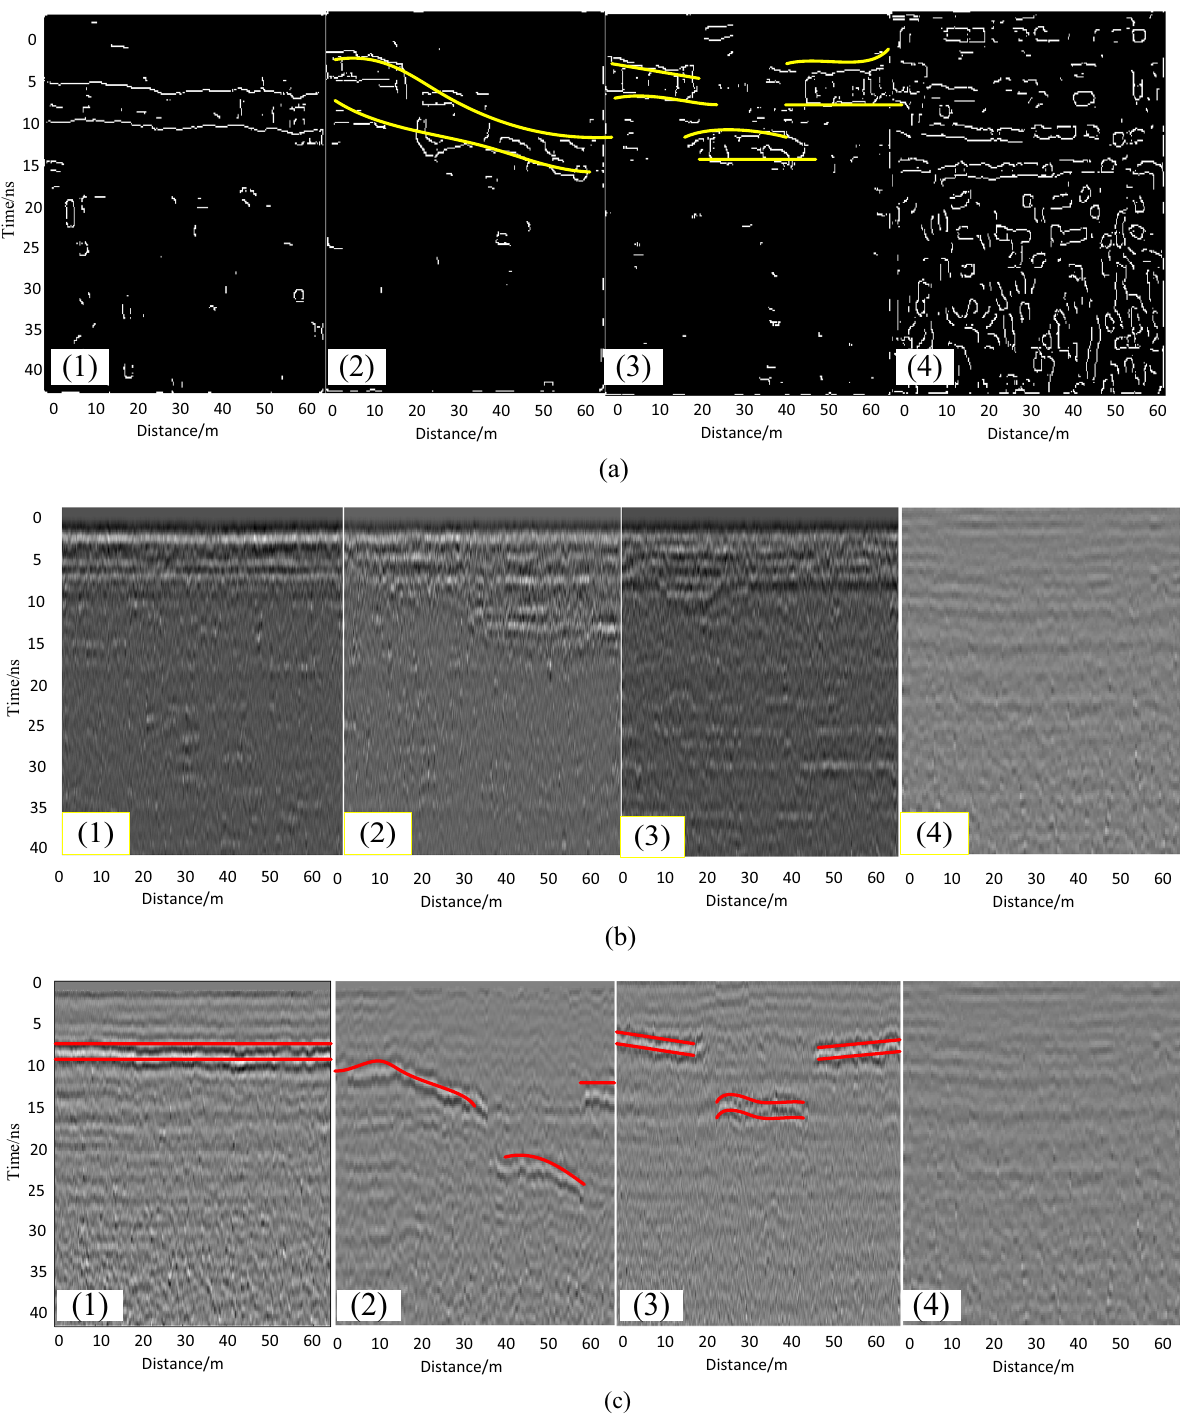
Figure 8. The radar images of subgrade: ( a ) CS images, ( b ) restored images, ( c ) original radar images, including (1) normal subgrade, (2) settlement, (3) sinkhole, (4) mud pumping,